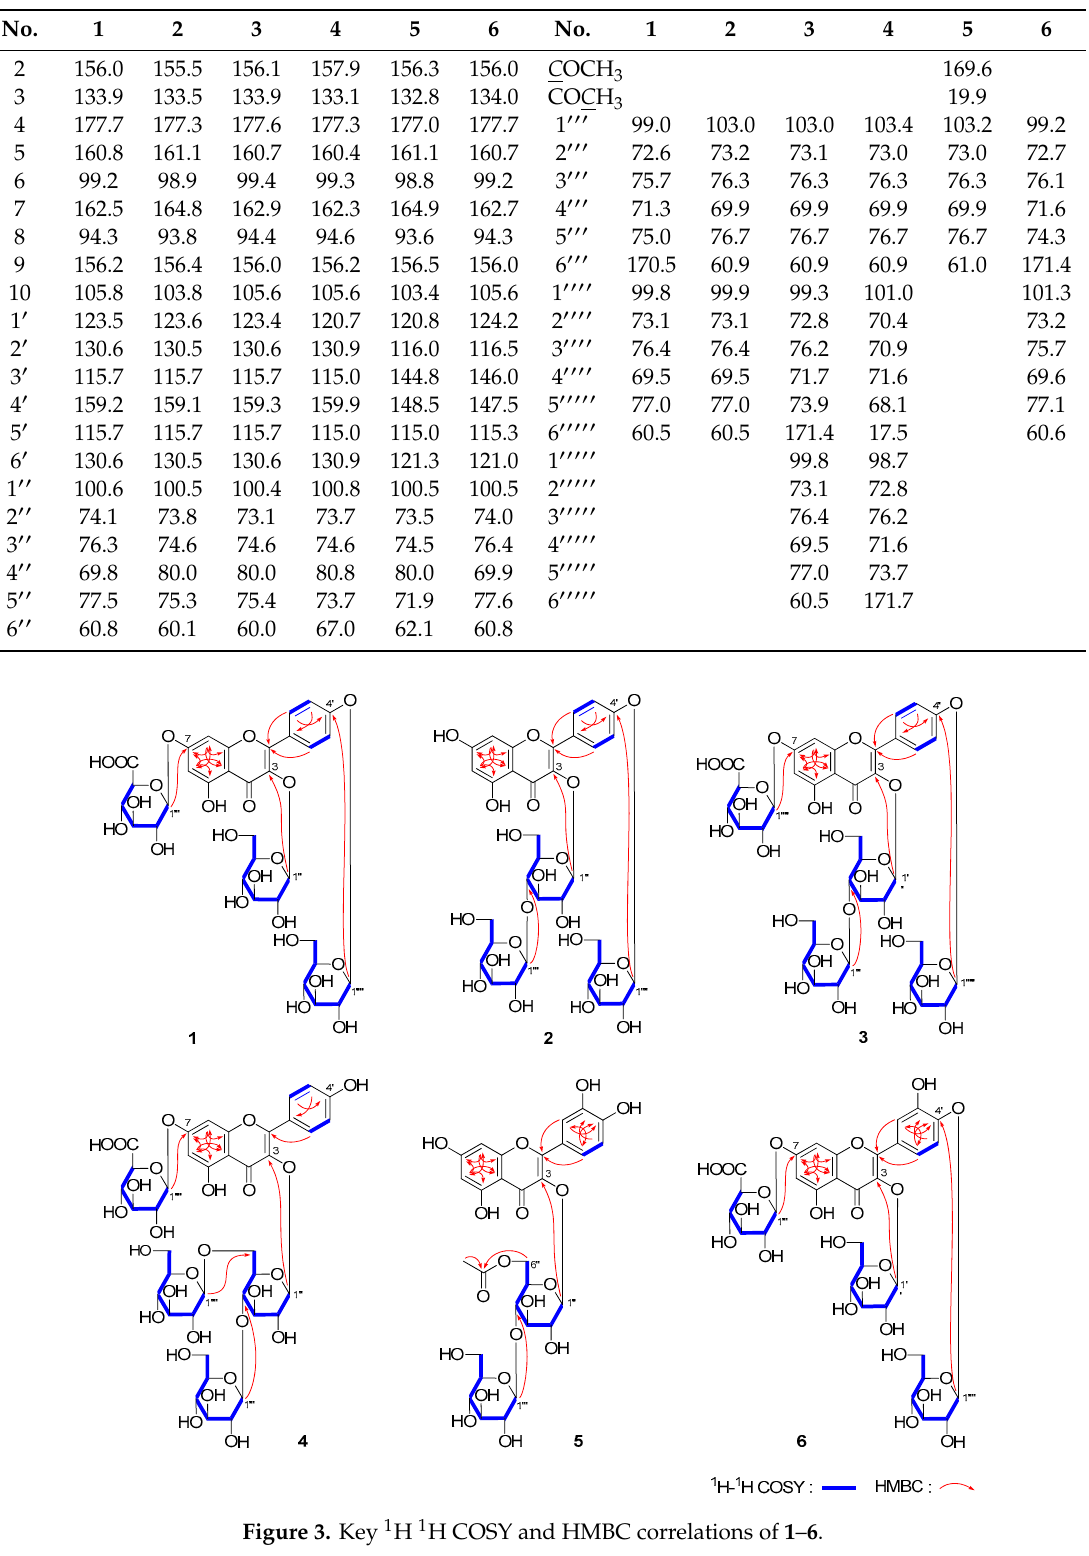
Table 1. 13 C-NMR data for 1 – 6 in DMSO- d 6 .